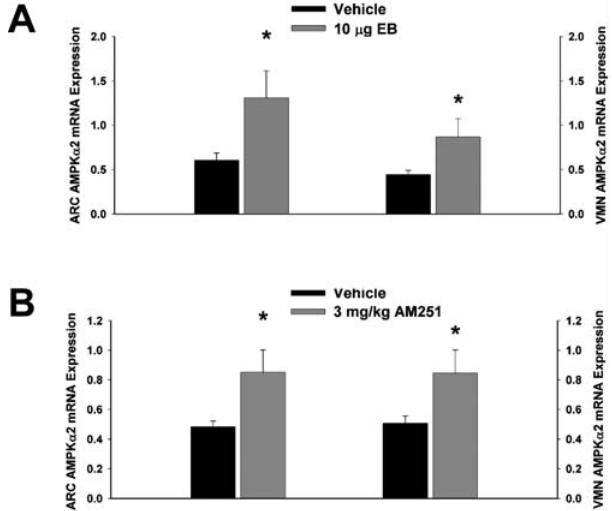
Figure 4. Both EB and AM251 increase AMPK α 2 expression in the ARC and VMN. Bars represent means and vertical lines 1 SEM of the AMPK α 2 catalytic subunit mRNA expression determined in ARC and VMN tissue harvested after the feeding